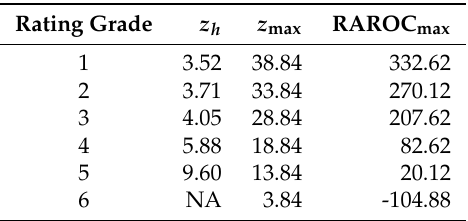
Table 5. Hurdle rate, maximum RAROC and z max for the unsecured installment loan Loan IV under the Standardized Approach. All results are percentage values.